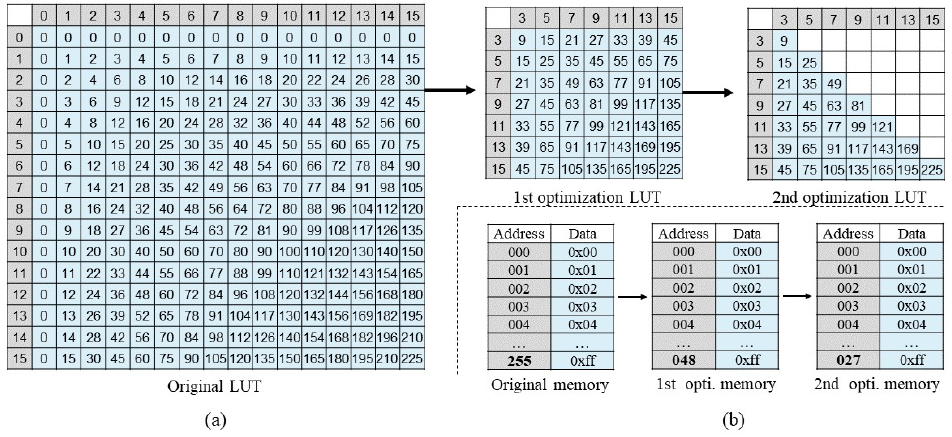
Figure 3. Optimization of 4-bit LUT. ( a ) 4-bit LUT optimization. 1st optimization decreases the even part of the input data pair; 2nd optimization decreases the same output by taking the diagonal as the boundary. ( b ) 4-bit LUT memory. After two optimizations, the number of storage entries are decreased from 256 to